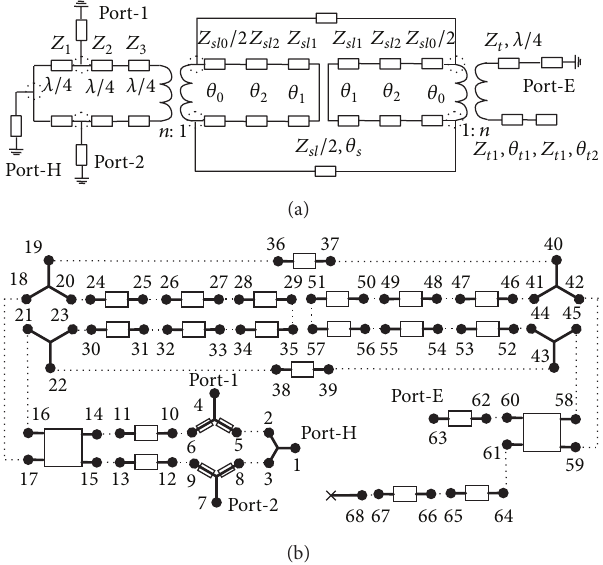
Figure4:Thecircuitdiagramsofthemagic-T.(a)Equivalentcircuit. (b) Decomposition circuit.